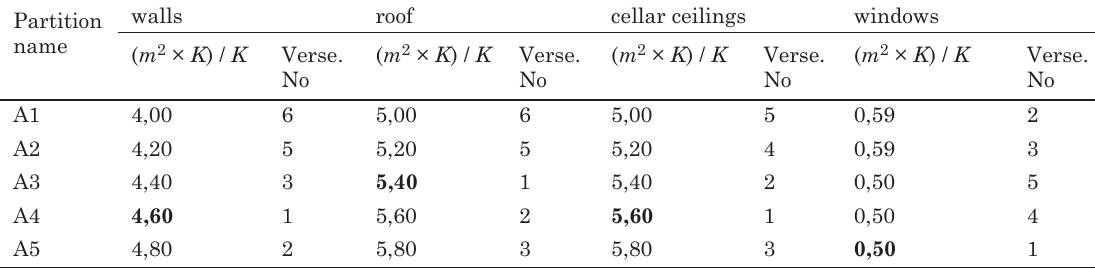
Table 8. Most effective building partitions